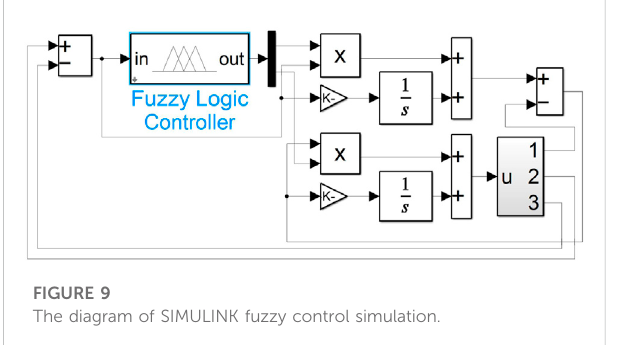
FIGURE 9 The diagram of SIMULINK fuzzy control simulation.